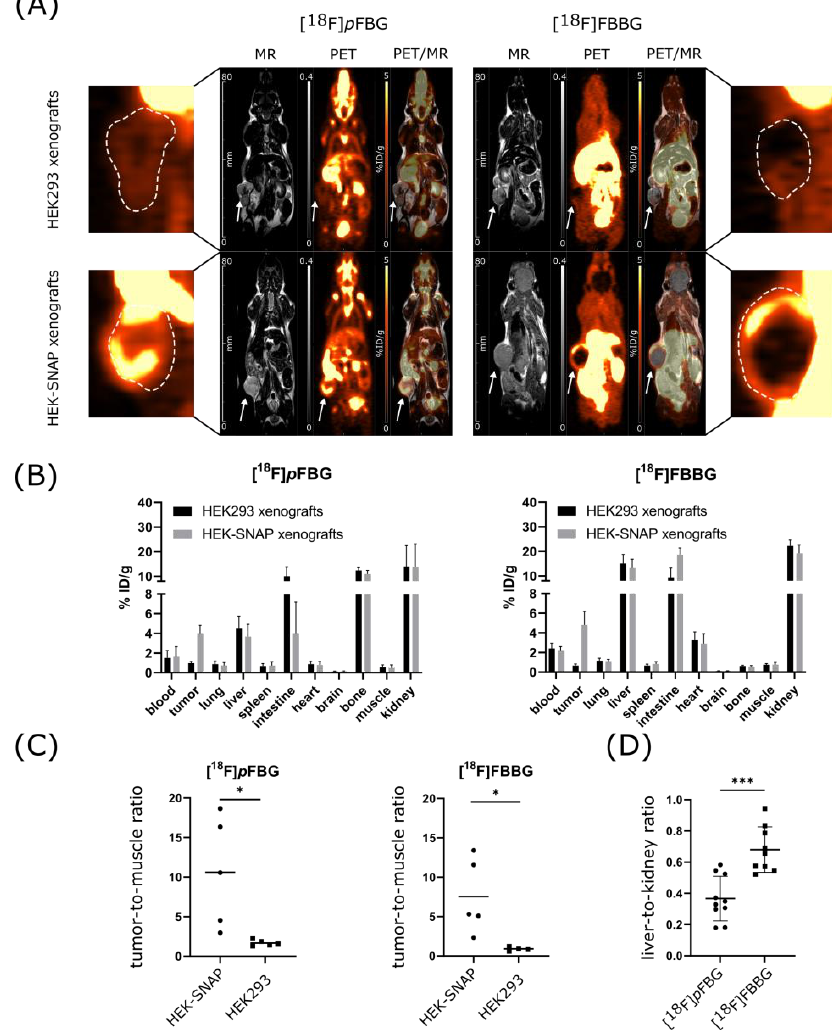
Figure 3. In vivo evaluation of [ 18 F] p FBG and [ 18 F]FBBG. ( A ) PET and MR images of representative mice with HEK-SNAP xenografts (upper images) or HEK293 control xenografts (lower images). Xenograft are indicated with white arrows and presented enlarged on the sides, outlined with a white dashed line. Images were taken after 1h of resting uptake. ( B ) Ex vivo biodistribution analysis by gamma-counting of [ 18 F] p FBG ( n = 5) and [ 18 F]FBBG ( n = 5 for HEK-SNAP, n = 4 for HEK293). ( C ) TMRs of HEK-SNAP and HEK293 xenografts imaged with either [ 18 F] p FBG ( n = 5 per group) or [ 18 F]FBBG ( n = 5 for HEK-SNAP and 4 for HEK293). ( D ) Liver-to-kidney ratios of [ 18 F] p FBG ( n = 10) and [ 18 F]FBBG ( n = 9). * p < 0.05, *** p <